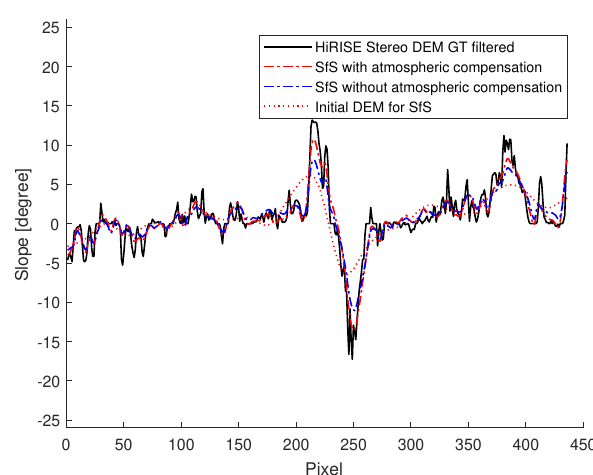
Figure 8. Slope of the profile from Figure